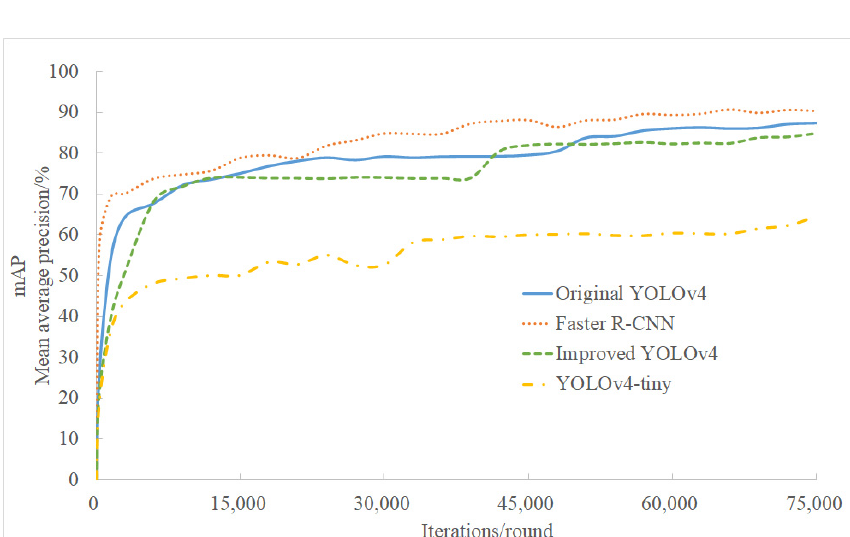
Figure 8. Loss value of the four models.